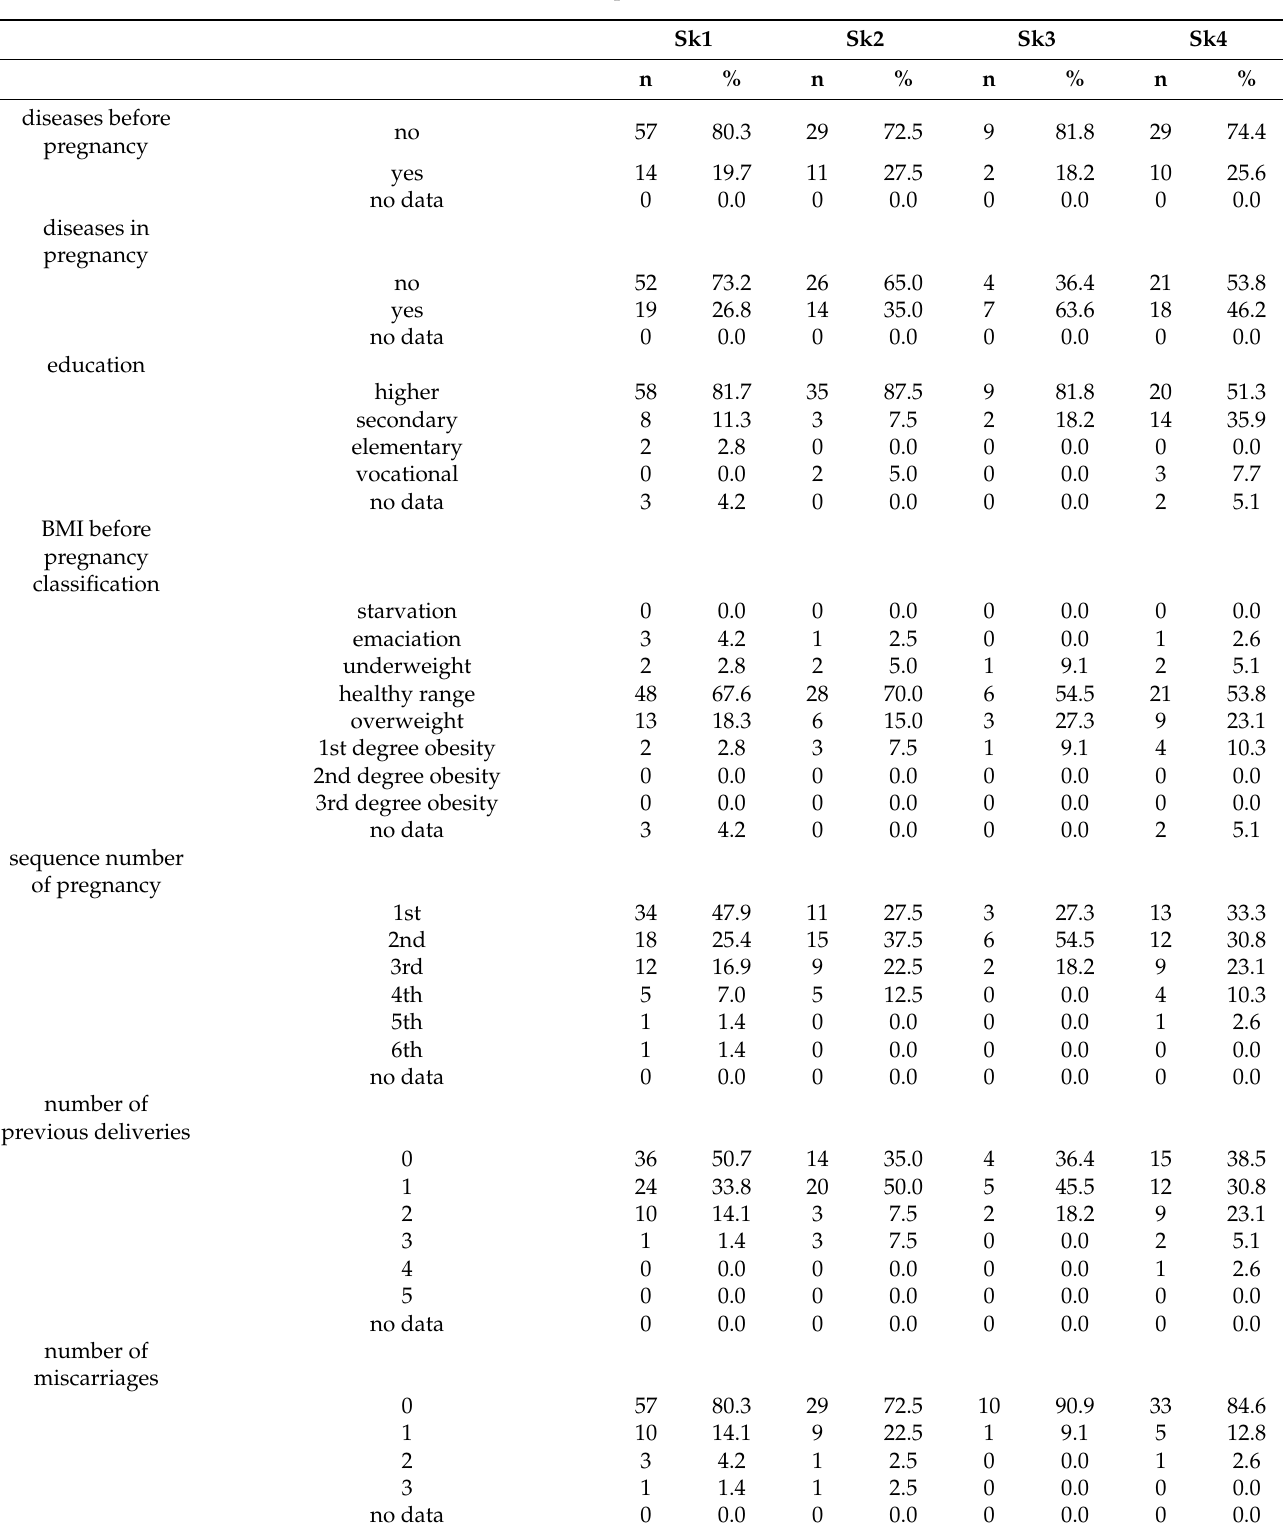
Table 4. Detailed characteristics of patients classified in individual